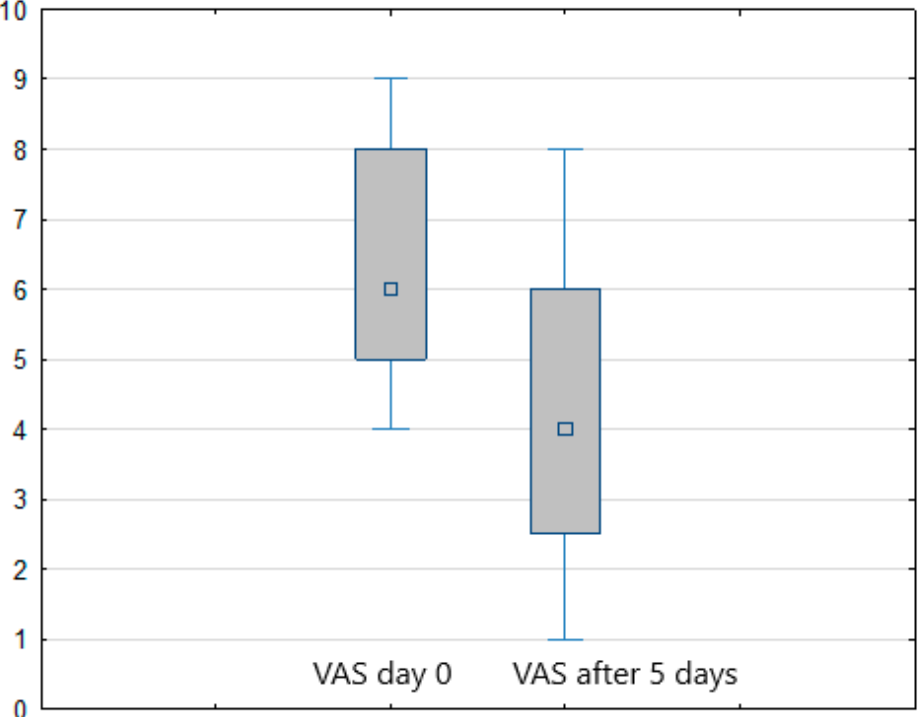
Figure 2. Reduction of pain (VAS score) in the sham-FREMS (+SOC) group after 5 days of treat- ment.